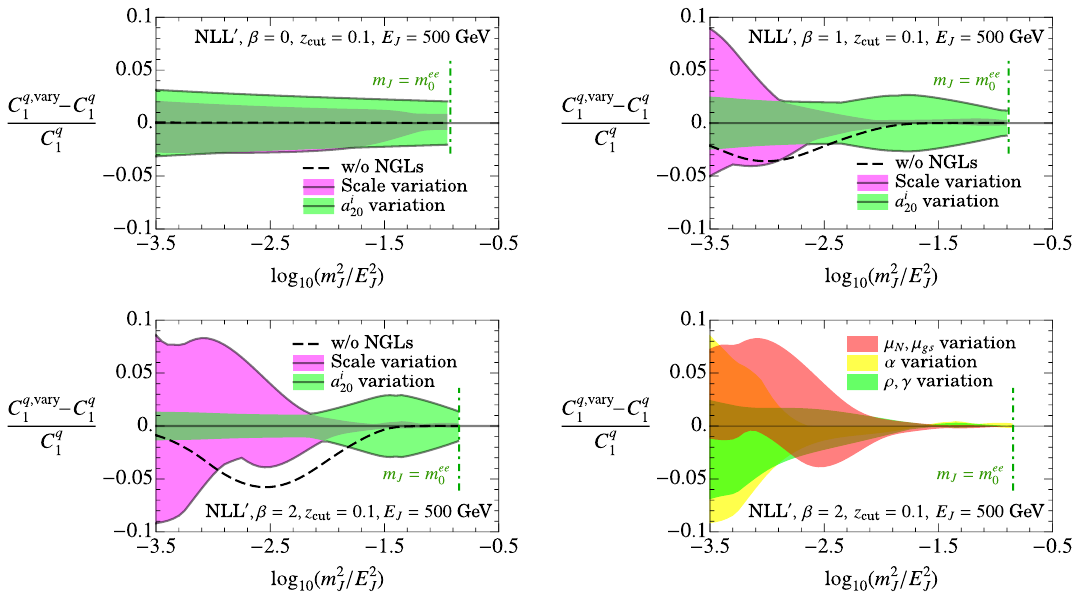
Figure 10 . Theoretical uncertainly on the NLL 0 predictions for C 1 , estimated through scale vari- ation (magenta) and by varying the two-loop fixed-order constant (green). When the jet mass is perturbative, both methods return very small uncertainty bands, thus we normalize variations to the central value for clarity. The black dashed curve shows the shift to the central value when NGLs are ignored. The bottom right panel shows the breakdown of the envelope of scale variation for β = 2 , labeled as in figure